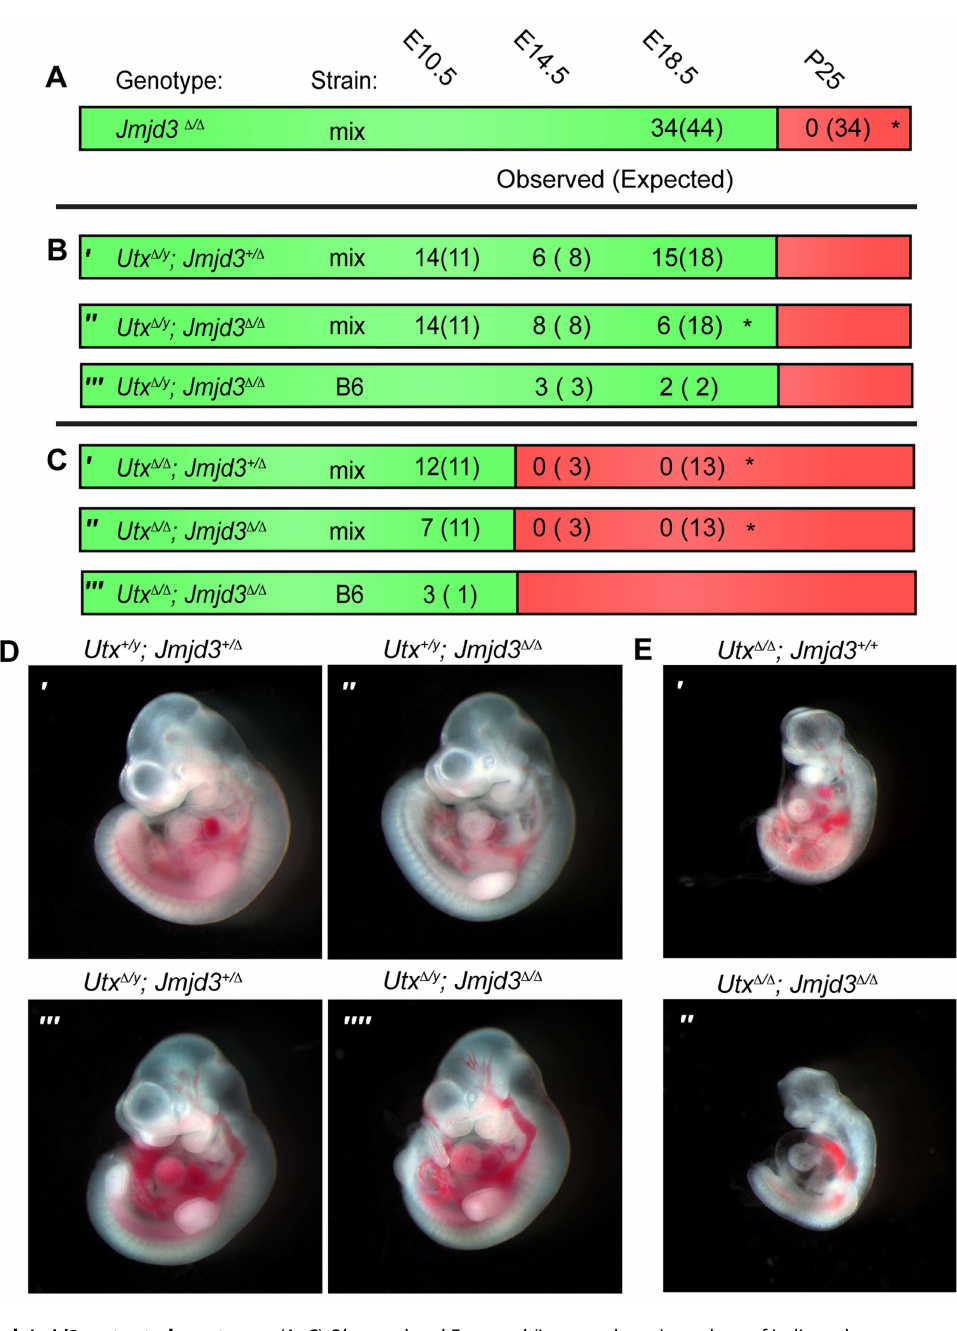
endogenous protein (Figure S4A and S4B). A 140-KD background band is present in Figure S4B and is not lost in Utx fl/y ; Jmjd3 fl/fl ; Cre ER ES + TX. To ensure that this is not an alternative